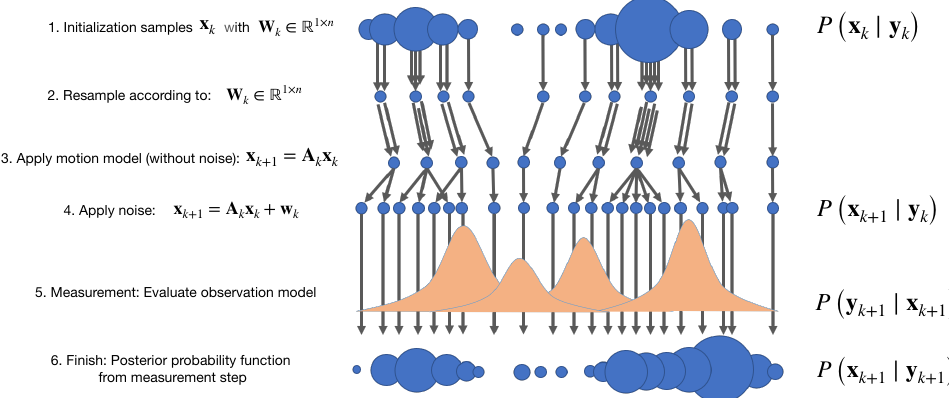
Figure 11. Particle Filter approach: (1) The particles associated with the a posteriori function at time k ; (2) resampling; (3) motion model to a priori function P ( x k + 1 | y k ) ; (4) observation at time k ; (5) posteriori function P ( x k + 1 | y k + 1 ) at time k + 1. Layer 1: In the first layer, we have n particles represented by circles of different sizes, indicating the importance of a particle W k ∈ R 1 × n